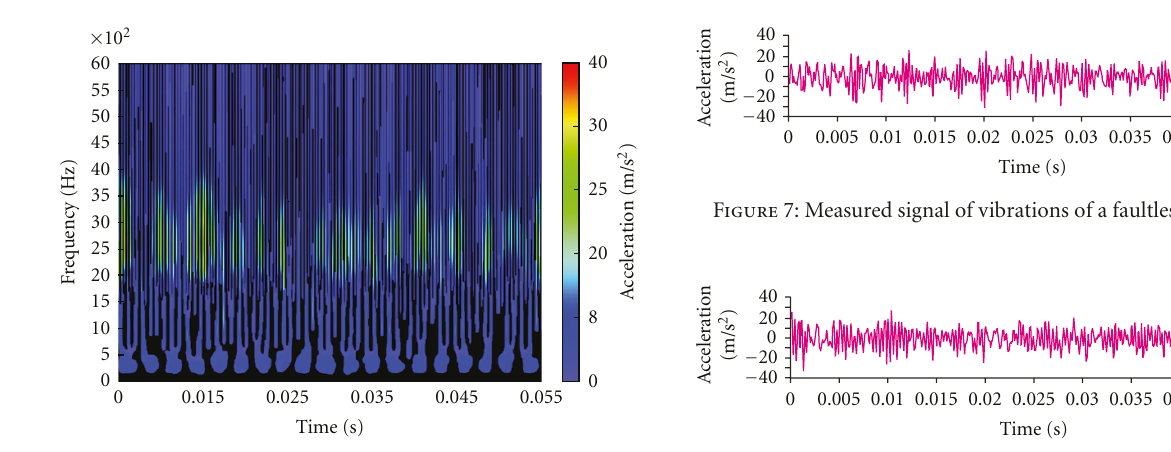
Figure 5: Frequency scalogram of wavelet coe ffi cient of the gear unit with a gear with a crack in a tooth root.